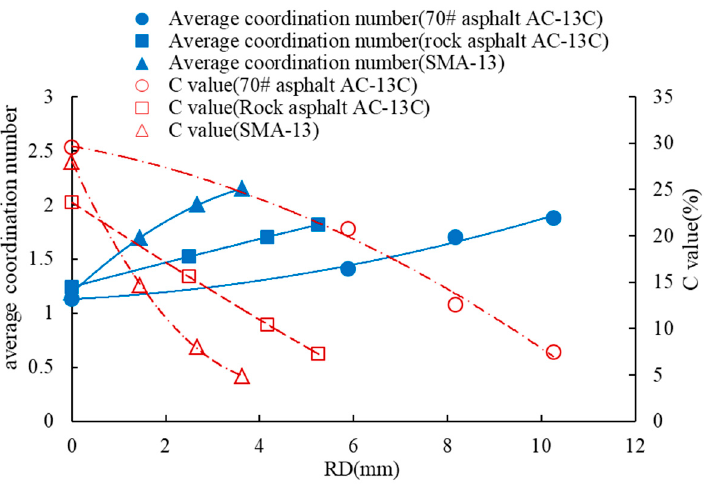
Figure 11. Relationship between n c , C value, and RD. Table 11. Corresponding mesoscopic and macroscopic indices when main skeleton reaches critical value.